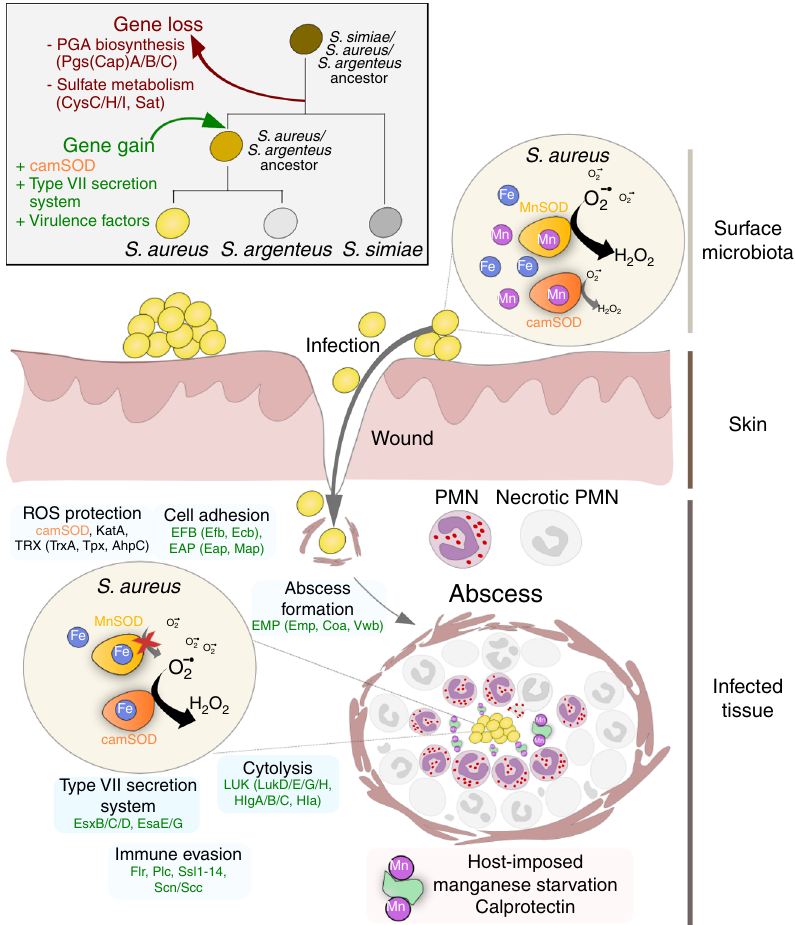
Fig. 7 Evolution of camSOD was driven by altered metal availability in the host. Schematic model depicting the evolution of S. aureus camSOD (orange) under selection pressure caused by exposure of the S. aureus ancestor to host-imposed manganese-starvation mediated by calprotectin. Acquisition and evolution of camSOD enabled the ancestor of S. aureus to maintain its antioxidant defense under these conditions using its iron-dependent catalysis, and coincided with its acquisition of numerous genes (green) involved in infection. Collectively, these acquired systems resulted in increased survival of S. aureus during interaction with host immune mechanisms, creating pathogenic S. aureus